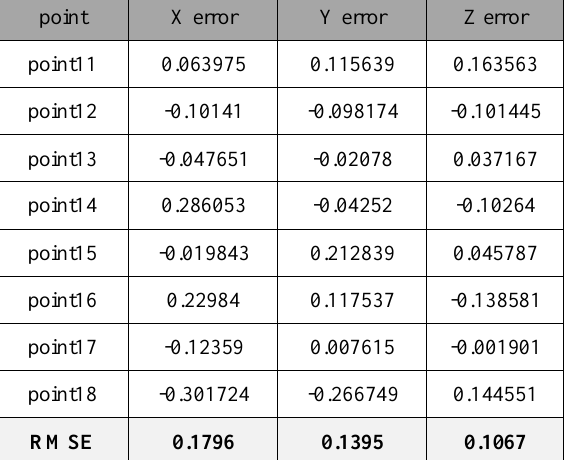
Table 4 The RMSE with check points (unit: m)